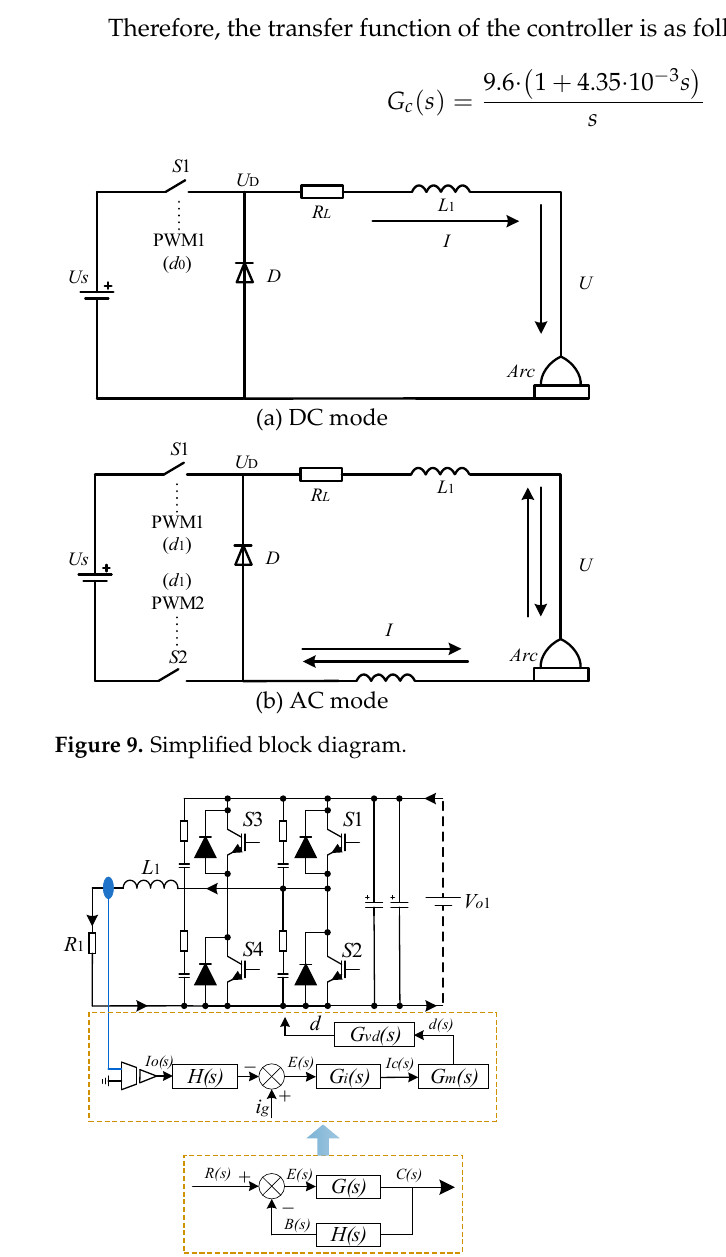
Figure 9. Simplified block diagram.